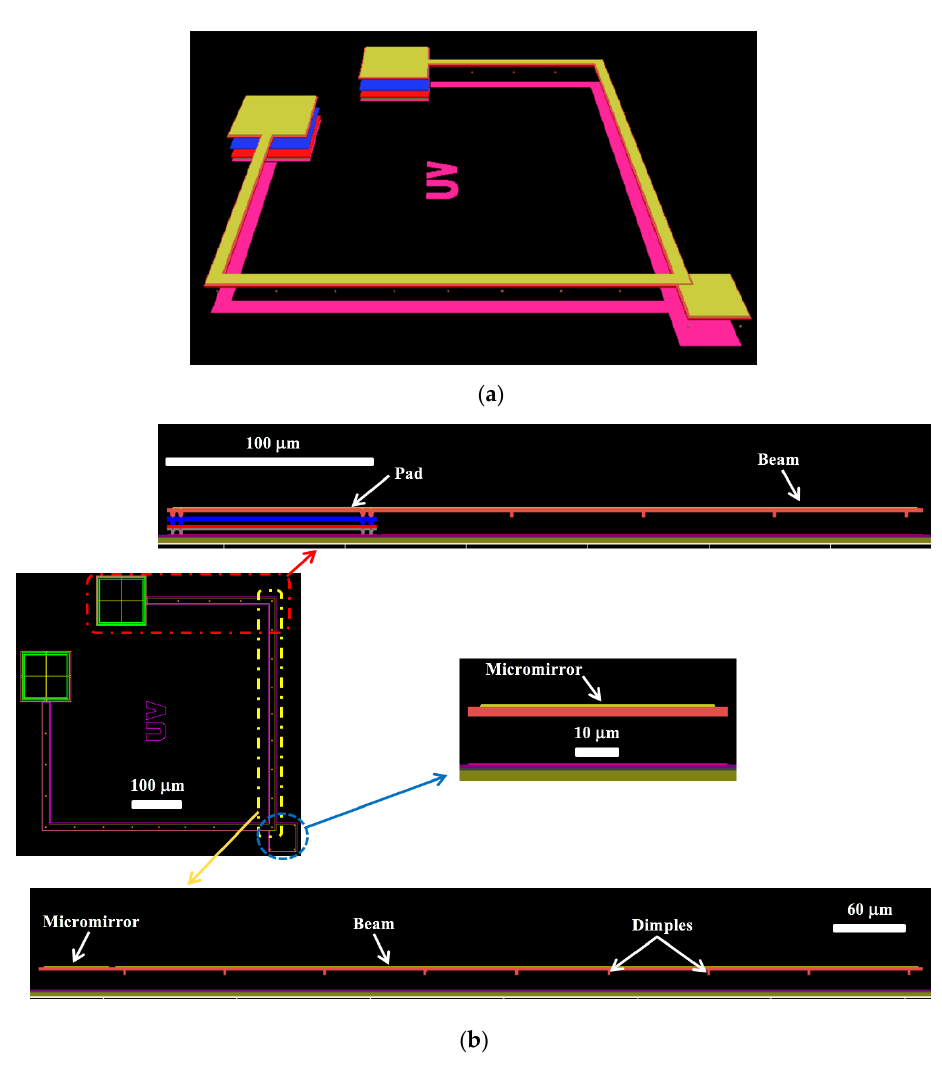
Figure 1. Layout of a magnetic field sensor with a polysilicon resonator, which is based on SUMMiT V process: ( a ) 3D; and ( b ) 2D view of the main mechanical components [19]. Reprinted with permission from [19]. Copyright© 2013, Bentham Science Publishers.